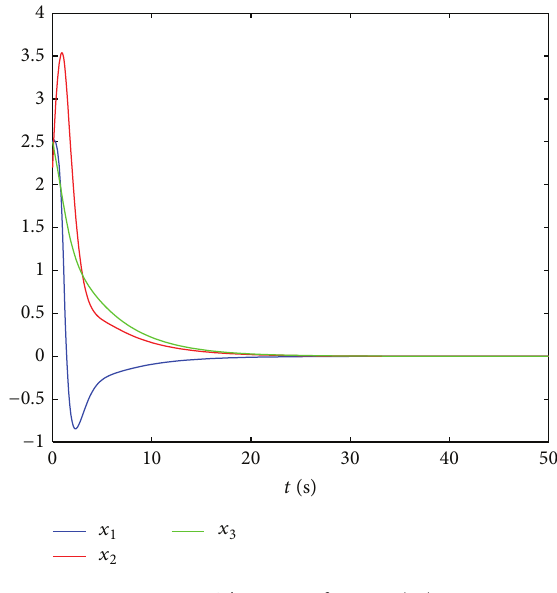
Figure 1: The states of system